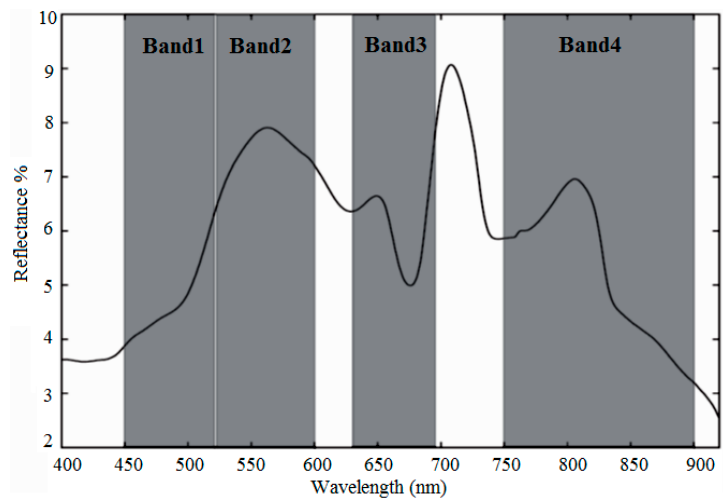
Figure 2. Spectral band positioning of Landsat7/ETM+ on ASD spectroradiometer spectrum [95].